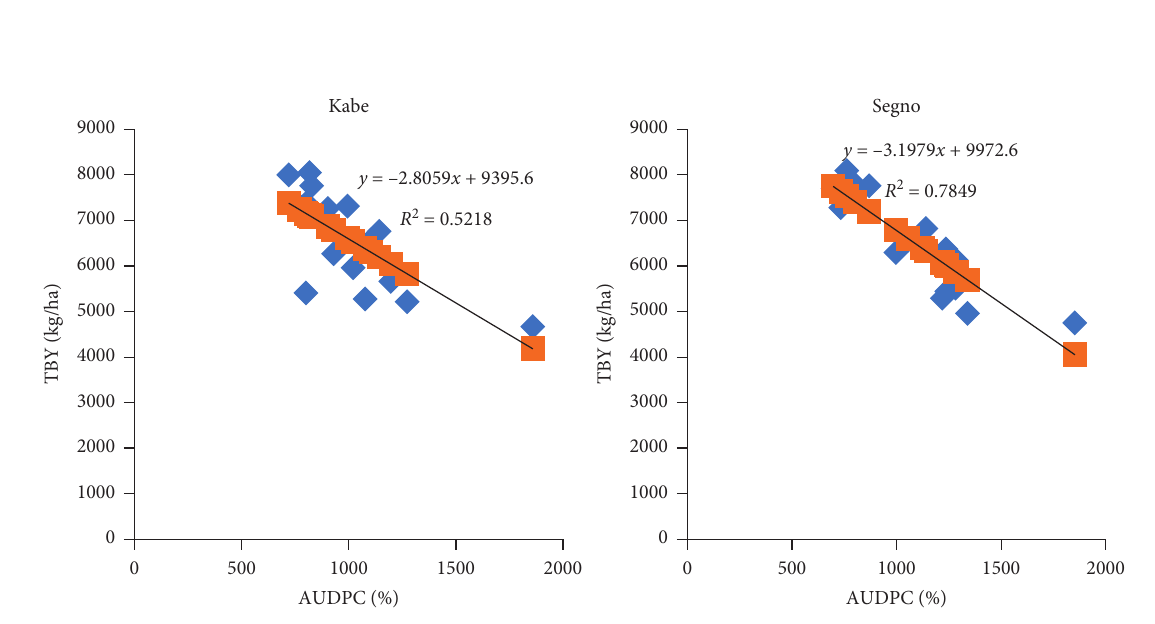
Figure 1: Linear regressions of garlic bulb yield and AUDPC at Kabe and Segno during the 2019 main cropping season.